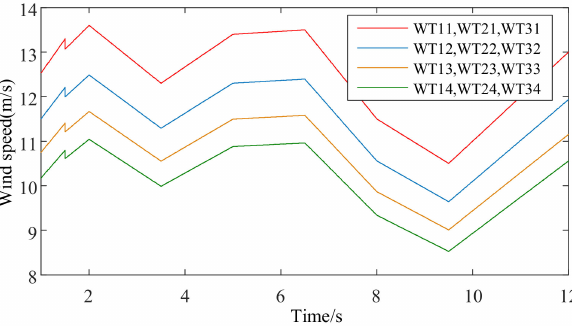
Figure 13. The input wind speed of each WT in Scenario 2.